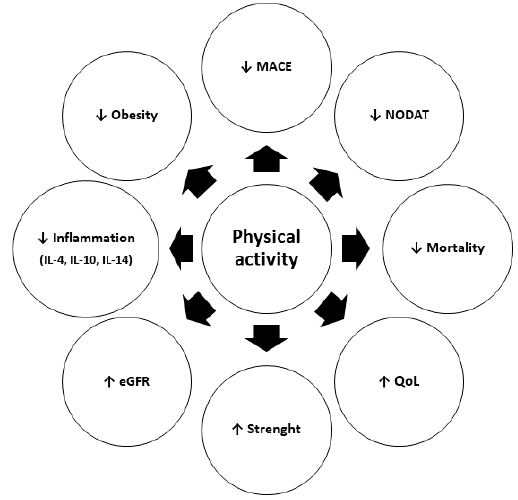
Figure 2. Positive effects of regular physical activity after kidney transplantation (MACE, major acute cardiovascular event; NODAT, new-onset diabetes after transplant; QoL, quality of life; eGFR, estimated glomerular filtration rate; ↑ , increased; ↓ , decreased).